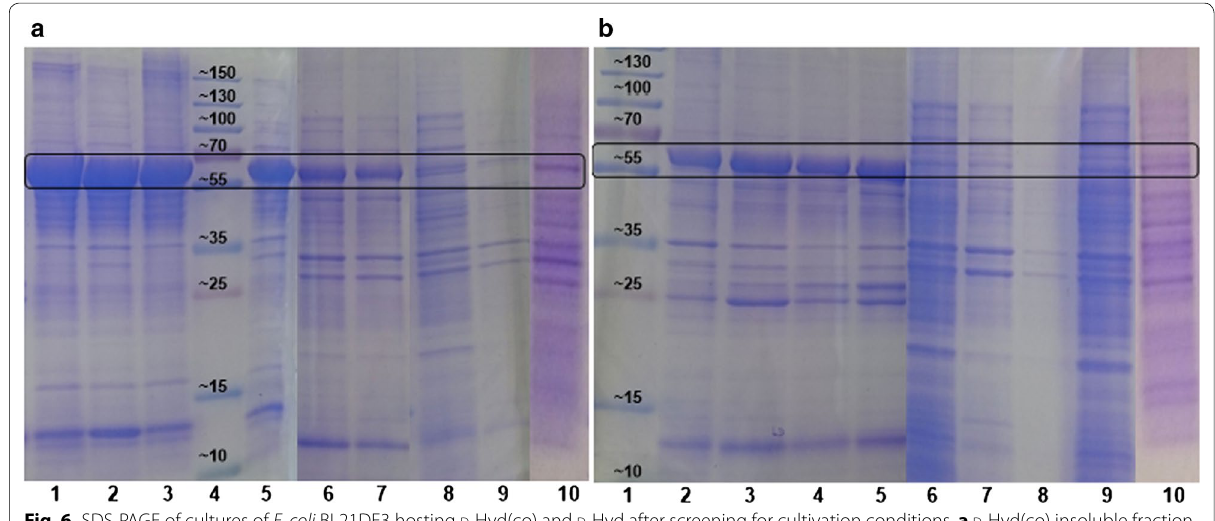
Fig. 6 SDS-PAGE of cultures of E. coli BL21DE3 hosting d -Hyd(co) and d -Hyd after screening for cultivation conditions. a d -Hyd(co) insoluble fraction, 1 IPTG EtOH pH 7, 2 IPTG EtOH pH 6, 3 IPTG EtOH pH 7, 4 protein standard with molecular weights in kDa, 5 + − + − + + EtOH pH 7, 7 IPTG EtOH pH 6, 8 IPTG EtOH pH 7, 9 IPTG EtOH pH 6, 10 soluble fraction. b d -Hyd insoluble fraction, 1 protein standard − − − − + − + with molecular weights in kDa, 2